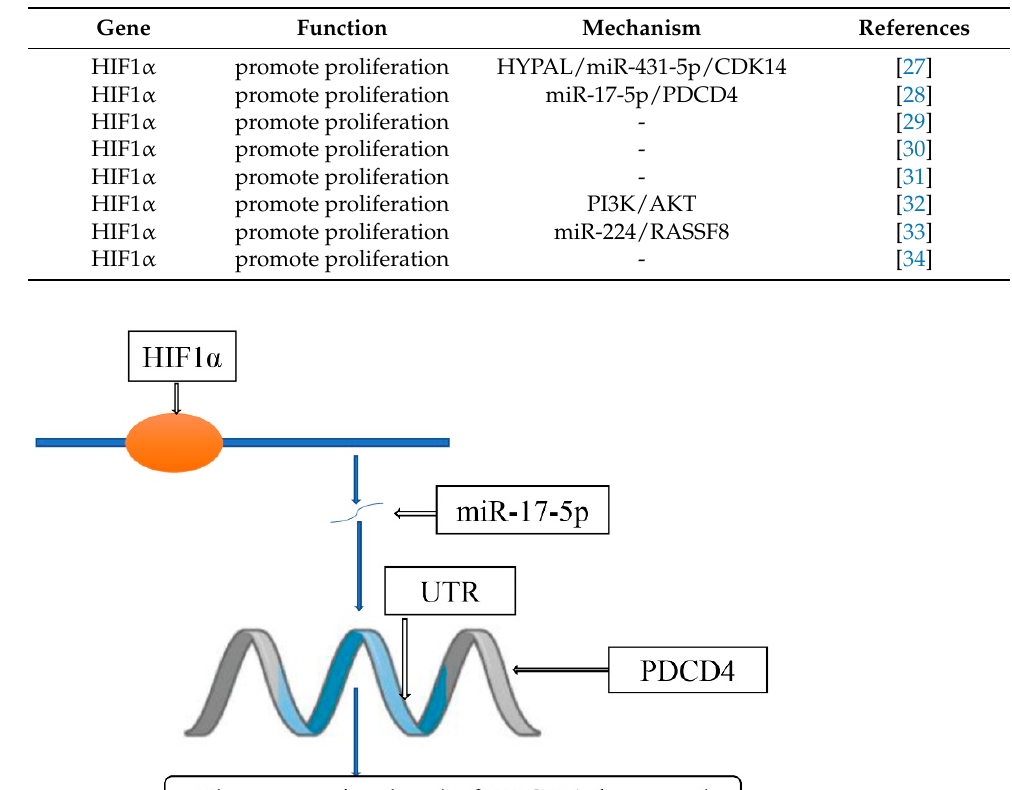
Table 1. HIF regulates gastric cancer progression by regulating tumor cell proliferation.